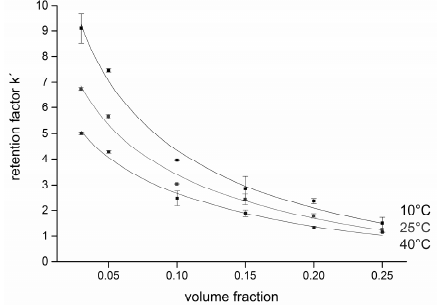
Figure 5. Verification of the retention model proposed by Jin et al. [24]. Experimental data were fitted with Equation (1) until the χ 2 tolerance of 10 − 6 was reached (Levenberg-Marquardt algorithm). The values of the coe ffi cients a, b, and c were as follows: +1.2, − 0.3, − 5.0 (upper curve, 10 °C); +1.0, − 0.3, − 5.0 (middle curve, 25 °C); +0.9, − 0.3, − 4.9 (lower curve, 40 °C). Error bars show the standard deviations of at least three replicates.